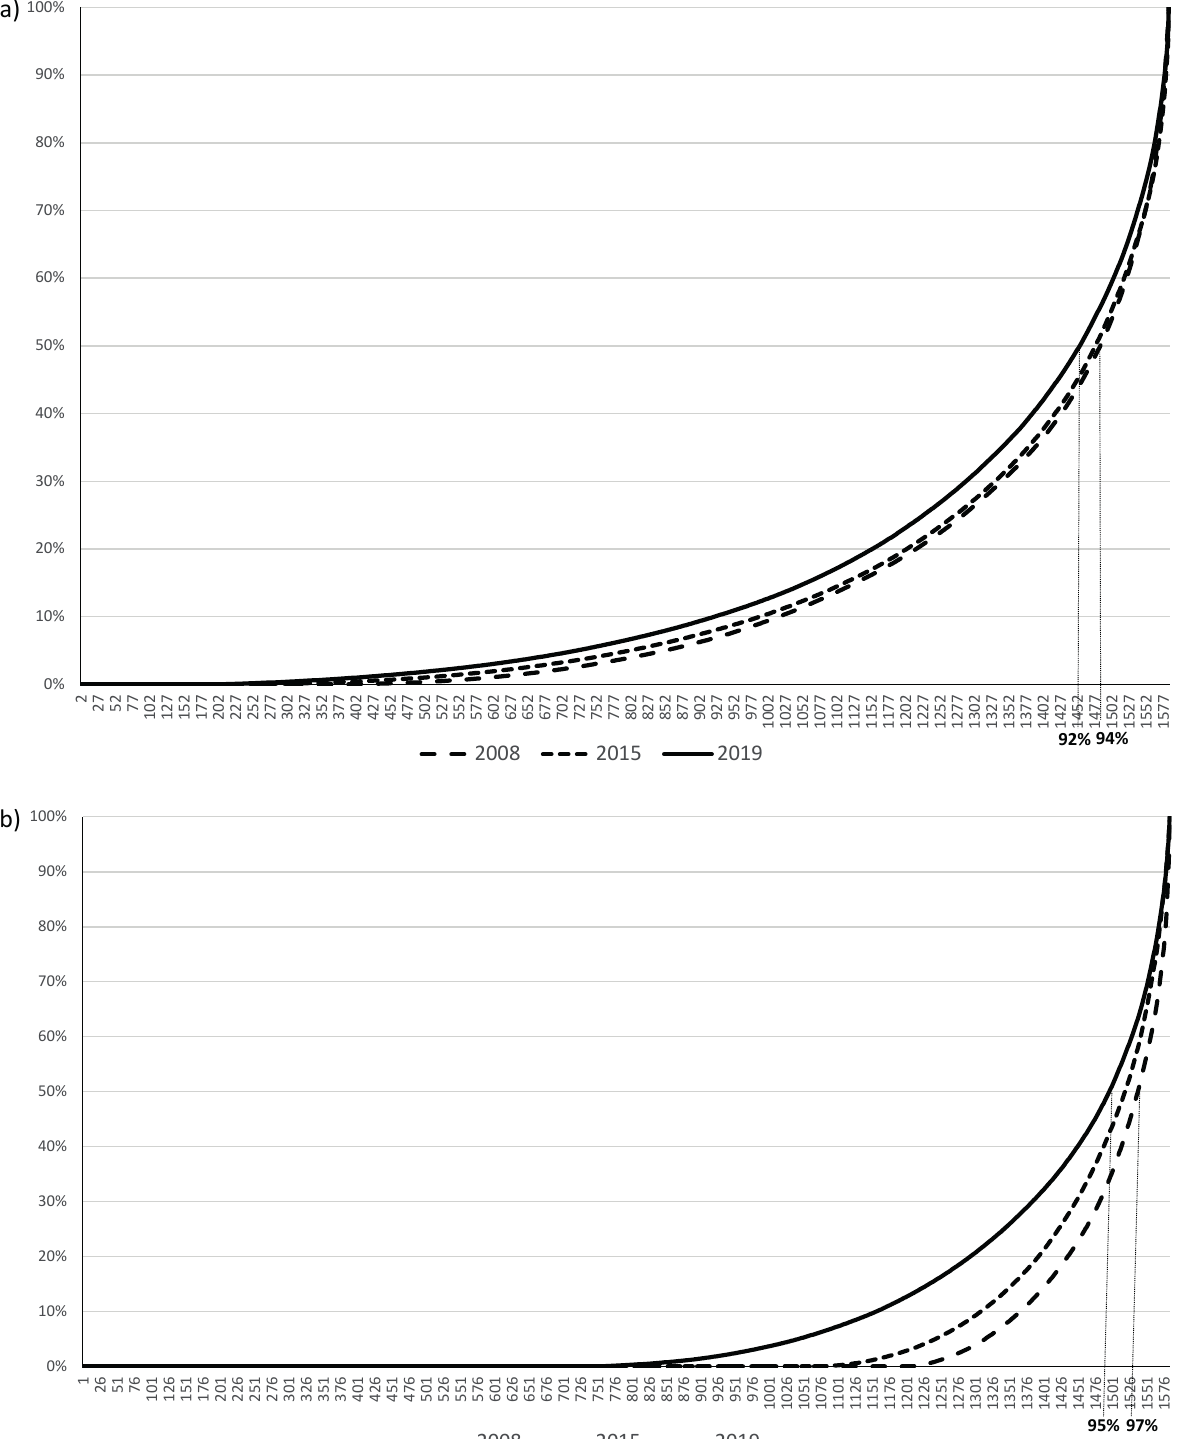
Figure A2 – Lorentz curves of the Pillar I (a) and Pillar II (b) support within the Italian 2008-2019 FADN balanced sample: years 2008, 2015,